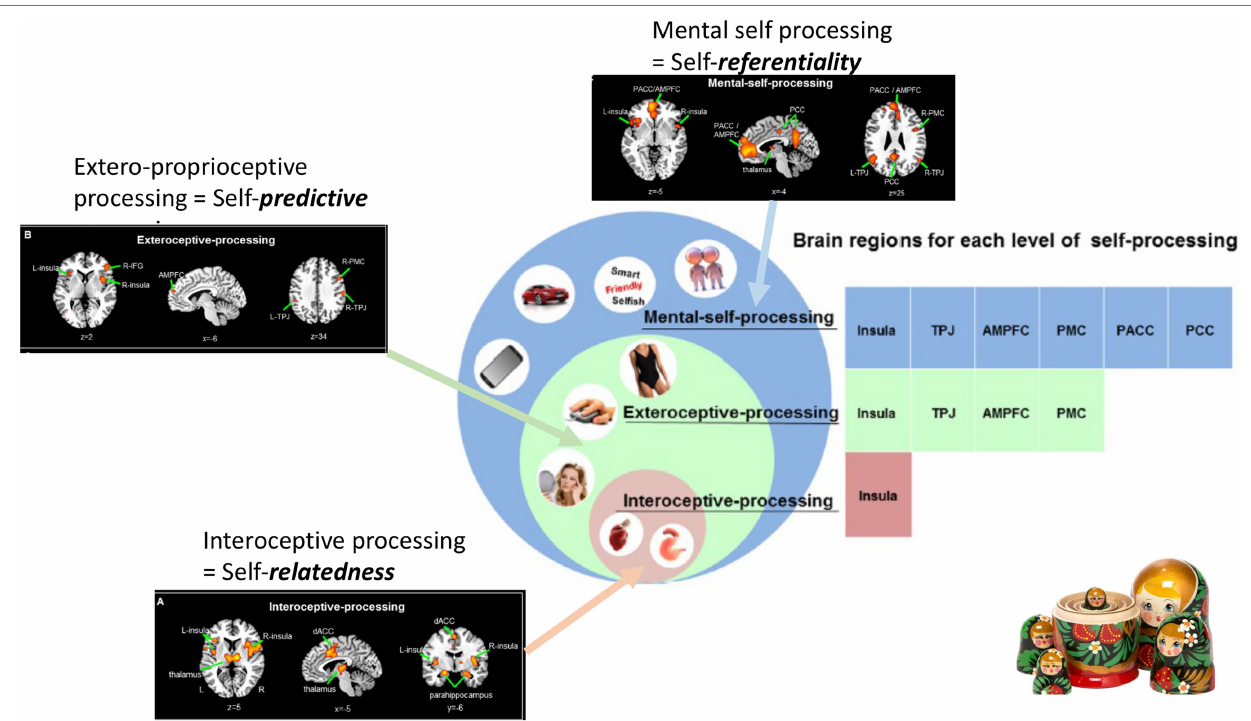
FIGURE 4 | Nested hierarchy of self in the brain with different regional layers of brain activity (black boxes on the left and upper middle) nesting in their regions within each other (brown, green and blue boxes on the right) resulting in a corresponding nestedness of different layers of self (brown, green, and blue circles in the